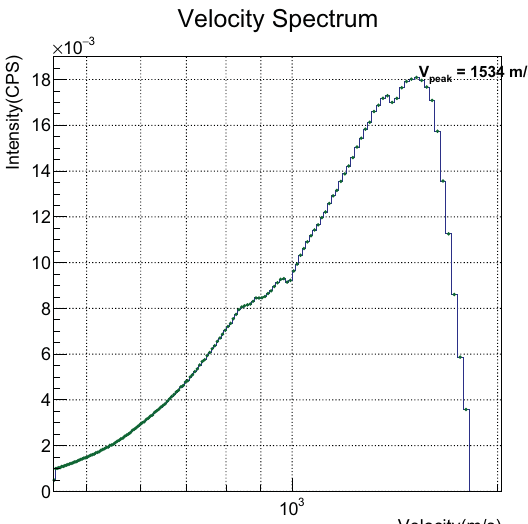
Figure 3. Velocity spectrum obtained from beam scan